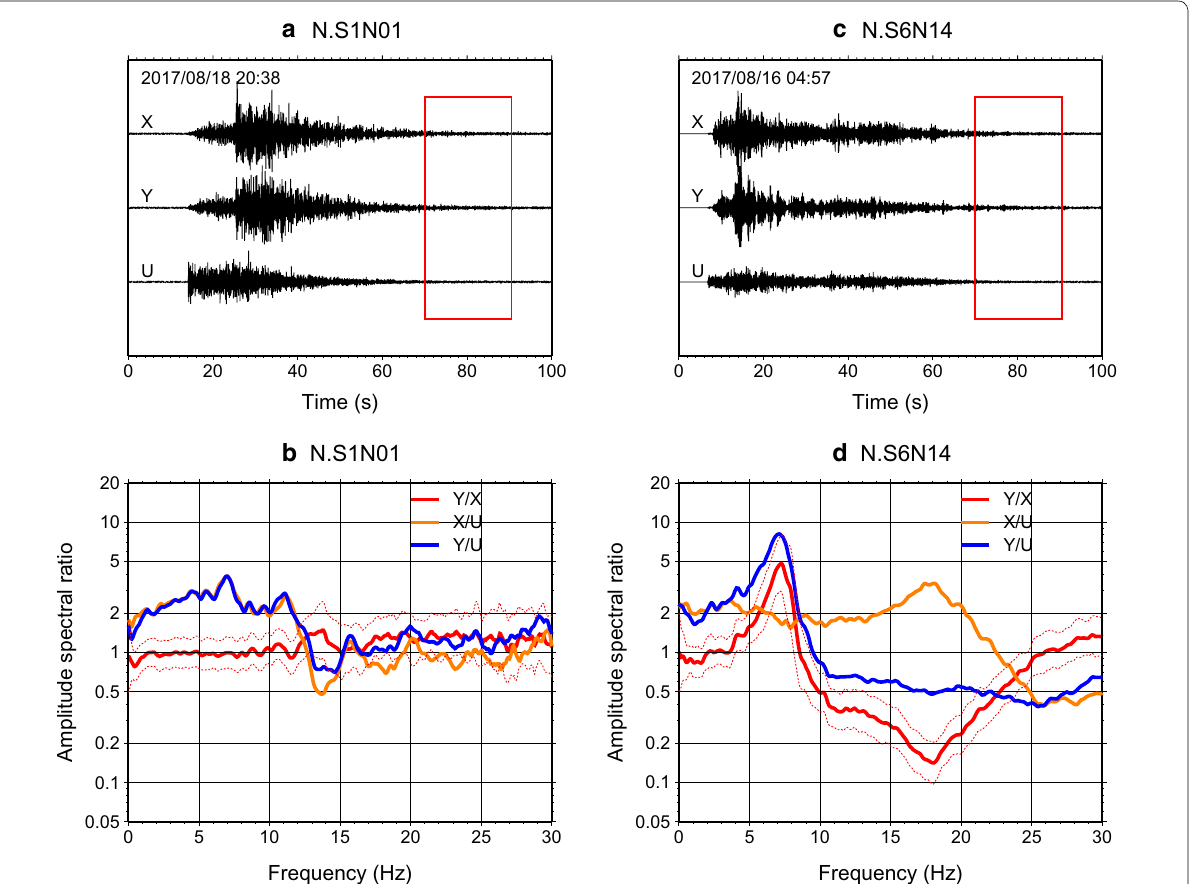
Fig. 1 Example of ( a , c ) three-component seismograms and ( b , d ) amplitude spectral ratios in the S-coda time window observed for two S-net stations. Locations of the two S-net stations ( a , b : N.S1N01, c , d : N.S6N14) are shown in Fig. 2a. Red rectangles are the S-coda time window used to compute the amplitude spectral ratios. Red, orange, and blue curves are the logarithmic averages of Y/X, X/U, and Y/U amplitude spectral ratios, respectively. Dotted red curves are the logarithmic standard deviation of the Y/X amplitude spectral